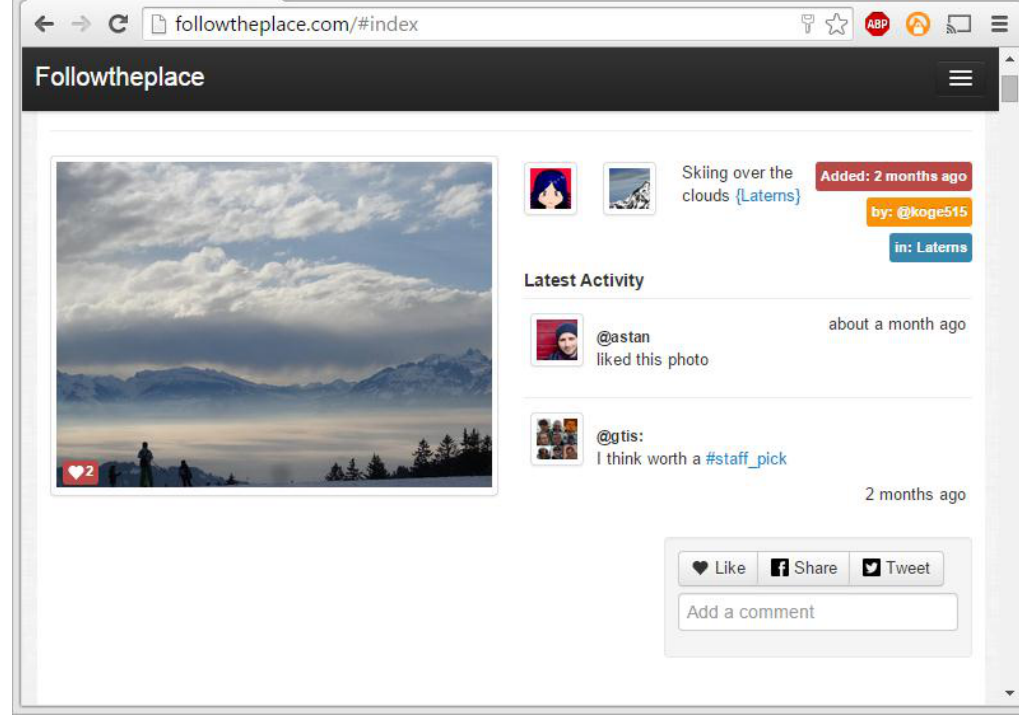
Figure 7. Screenshot of FollowThePlace app showing the user interface